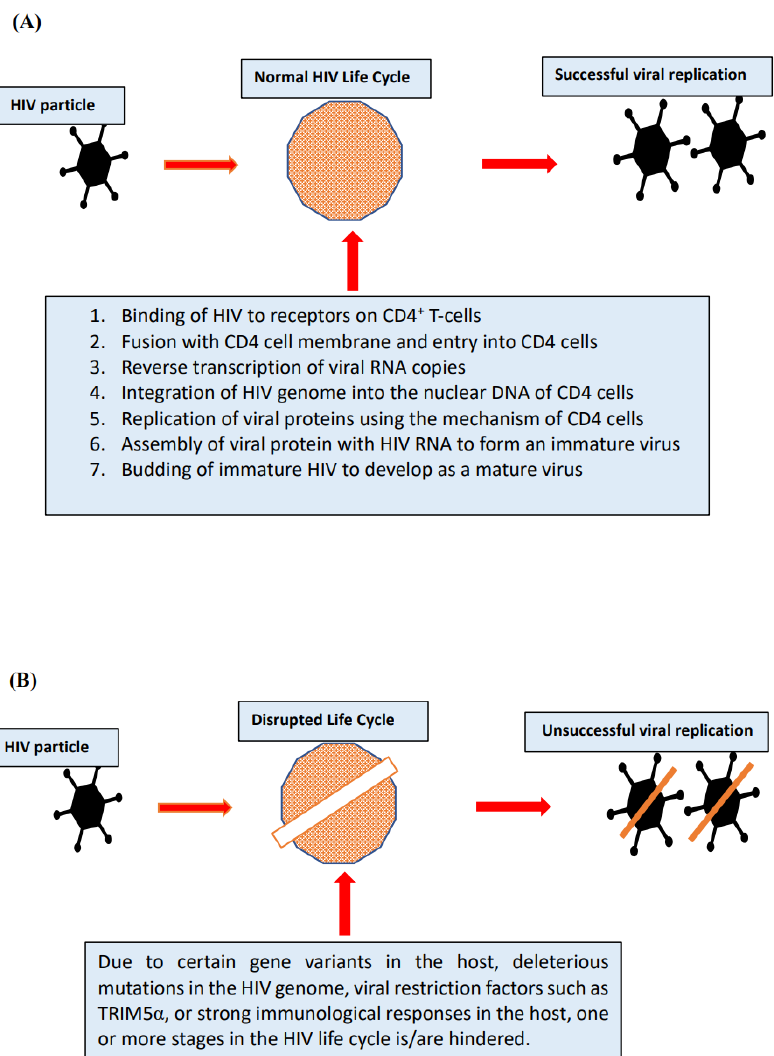
Figure 1. Understanding the mechanism of viral suppression and favorable disease outcomes among HIV elite controllers and other HIV controllers. ( A ) Without the influence of barriers, such as antiretroviral drugs, or unique features that contribute to viral suppression among the elite controllers, viraemic controllers, or long-term nonprogressors, HIV replicates successfully and infects new CD4 + T cells. This eventually causes a high viral load in the host system. ( B ) In HIV controllers, such as elite controllers and viraemic controllers, one or more of the stages of HIV’s life cycle is inhibited or interrupted by (i) host unique features such as potent immune responses that are capable of effectively neutralizing, engulfing, or lysing HIV-infected cells; favorable genetic variants that do not support HIV replication; viral restriction factors that are host-acting proteins that provide first-line protection against infection of new host cells; (ii) viral factor, specifically, deleterious mutations in the HIV genome that may cause loss of fitness during viral replication. The mechanism of the nonprogressive phenotype in HIV infection can therefore be explicitly delineated when specific features that favor positive disease outcomes among the HIV controllers are